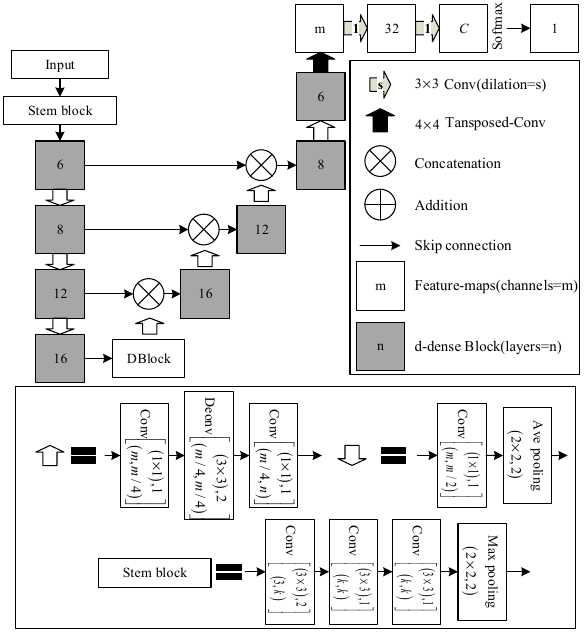
Figure 7. The proposed network construction with the D-Dense block.